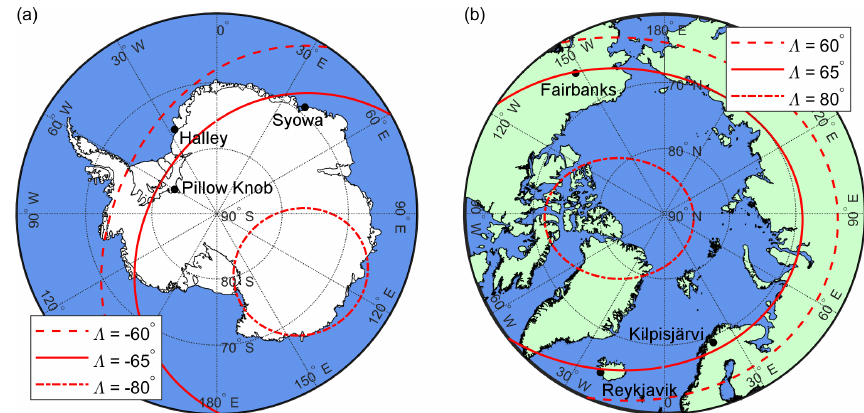
Figure 1. Maps of (a) the Southern Hemisphere and Antarctica poleward of geographic latitude 60 ◦ S and (b) the Northern Hemisphere and Arctic region poleward of geographic latitude 60 ◦ N. The red dashed, solid, and dotted–dashed lines on each map show the geomagnetic latitudes (cid:51) = ± 60 ◦ , (cid:51) = ± 65 ◦ , and (cid:51) = ± 80 ◦ respectively, calculated for 1 January 2015 and an altitude of 80km using the IGRF-12 internal field model (Thébault et al., 2015). Black filled circles indicate the locations of Halley station (75 ◦ 37 (cid:48) S, 26 ◦ 15 (cid:48) W, (cid:51) = − 62 . 3 ◦ ), Syowa station (69 ◦ 00 (cid:48) S, 39 ◦ 35 (cid:48) E, (cid:51) = − 66 . 6 ◦ ), and Pillow Knob refuelling station (82 ◦ 30 (cid:48) S, 60 ◦ 00 (cid:48) W, (cid:51) = − 67 . 3 ◦ ) in (a) and Kilpisjärvi (69 ◦ 03 (cid:48) N, 20 ◦ 49 (cid:48) E, (cid:51) = 66 . 2 ◦ ), Finland; Reykjavik (64 ◦ 08 (cid:48) N, 21 ◦ 56 (cid:48) W, (cid:51) = 64 . 4 ◦ ), Iceland; and Fairbanks (64 ◦ 51 (cid:48) N, 147 ◦ 43 (cid:48) W, (cid:51) = 65 . 2 ◦ ), Alaska, in (b) .